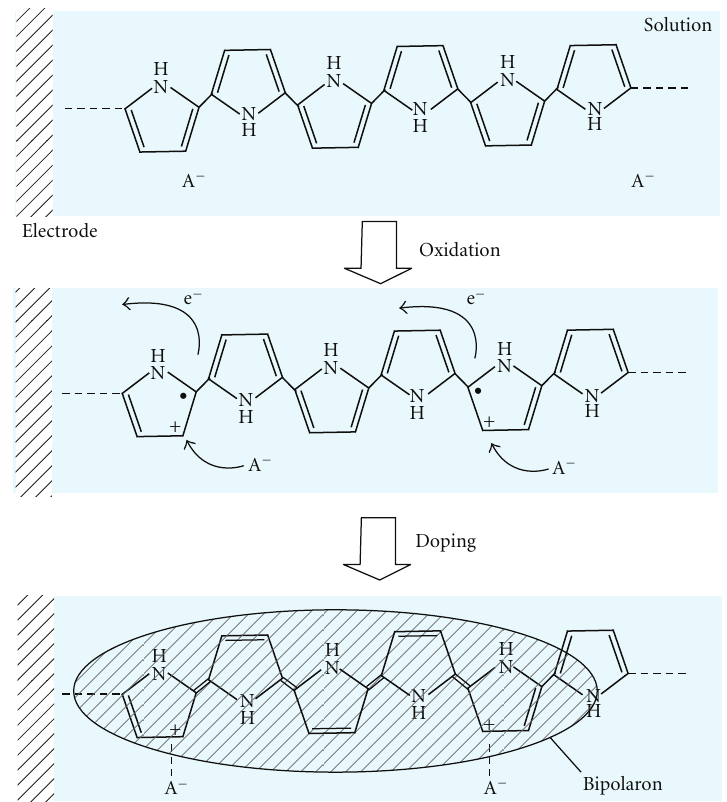
Figure 3: Electrochemical oxidation of neutral nonconducting PPy. During the oxidation, electron transfer from PPy to substrate steel and doping of anions from electrolyte solution to PPy simultaneously